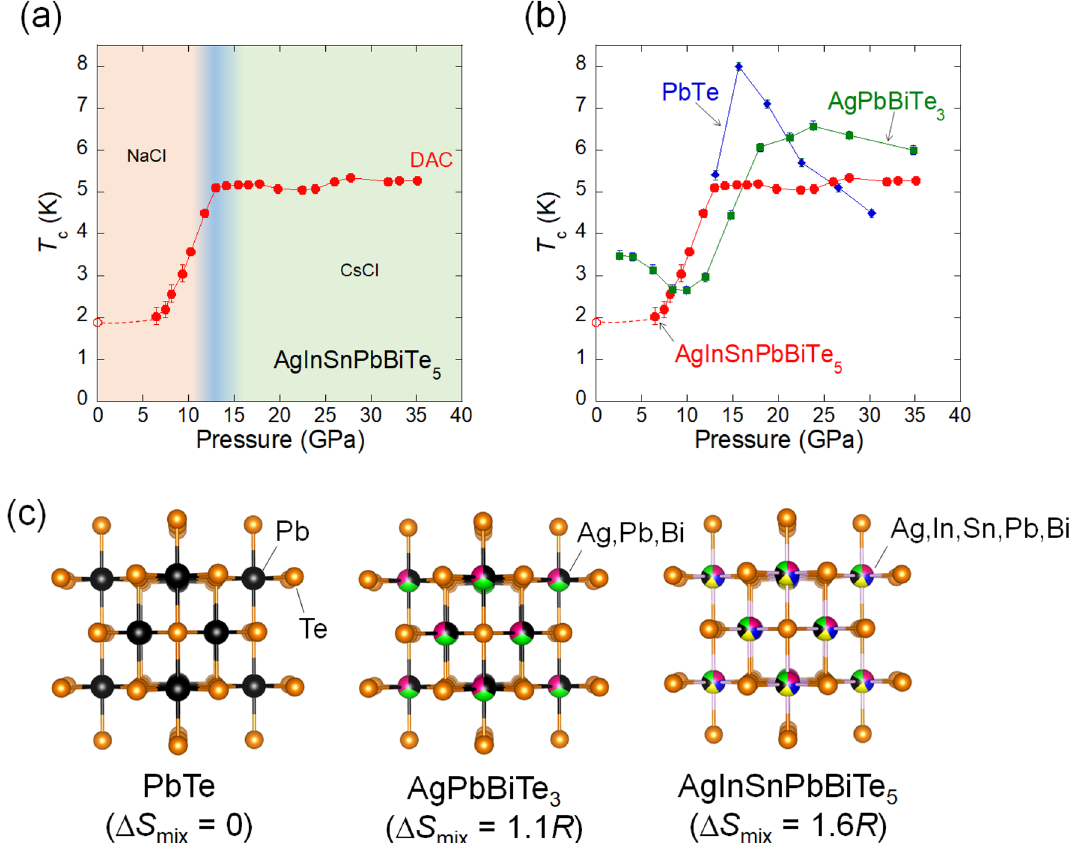
Figure 2. Pressure evolutions of T c of metal tellurides with different configurational entropy of mixing. ( a ) onset Pressure dependence of T c of AgInSnPbBiTe 5 . Open and filled circles indicate the data taken without a pressure cell, and the data that was measured with DAC. The structural types are indicated according to onset structural analyses in Fig. 3d. ( b ) Pressure dependences of T c for PbTe, AgPbBiTe 3 , and AgInSnPbBiTe 5 . ( c ) Schematic images of NaCl-type crystal structure and configurational entropy of mixing (Δ S mix ) at the M site of PbTe, AgPbBiTe 3 , and AgInSnPbBiTe 5